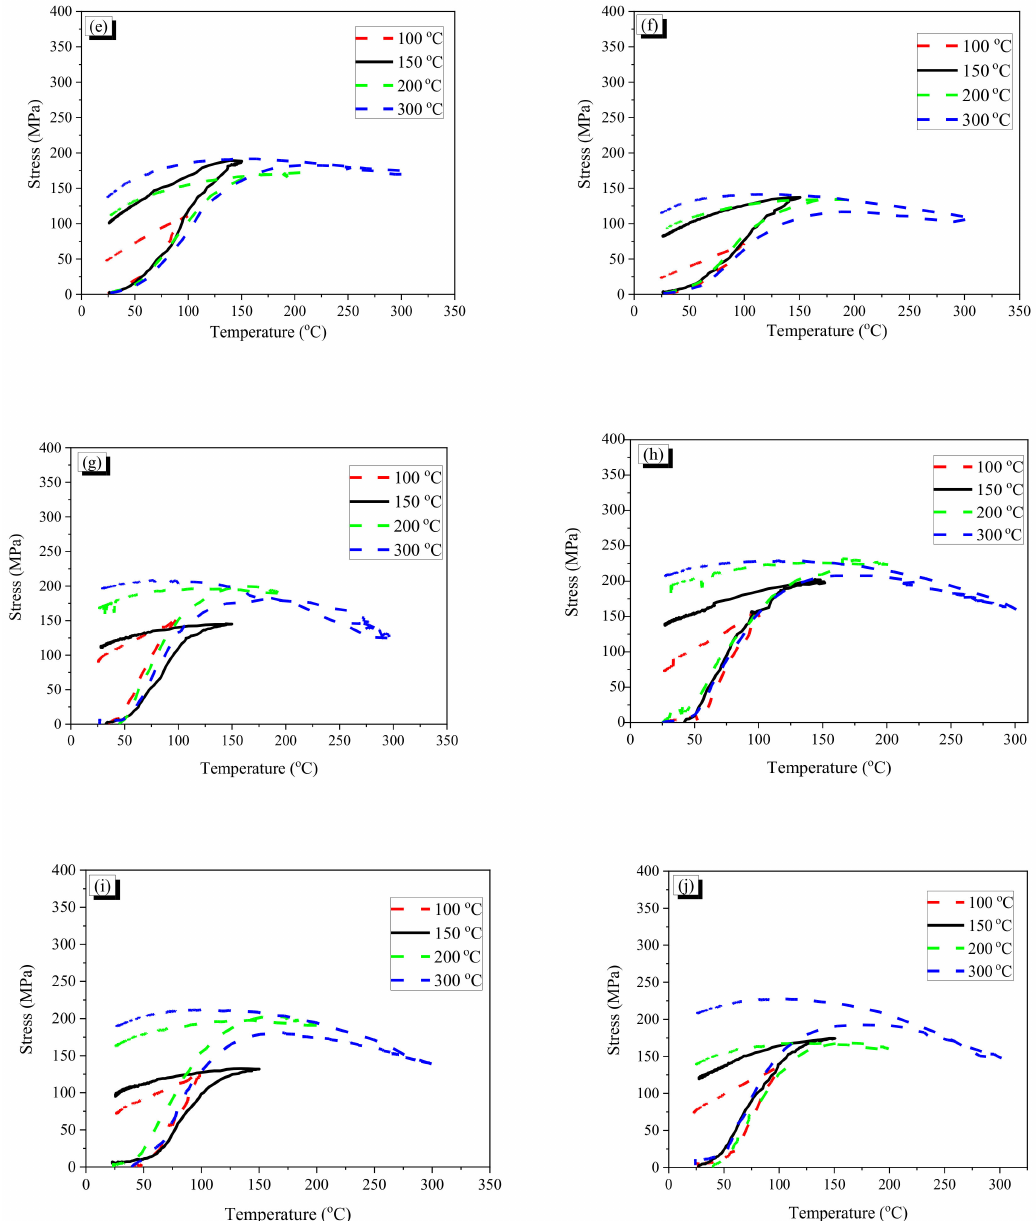
Figure 8. Temperature–stress curves of AR and crimped fibers: ( a ) AR1.0 fiber; ( b ) AR0.7 fiber; ( c ) CR1.0-1 fiber; ( d ) CR1.0-2 fiber; ( e ) CR1.0-3 fiber; ( f ) CR1.0-4 fiber; ( g ) CR0.7-1 fiber; ( h ) CR0.7-2 fiber; ( i ) CR0.7-3 fiber; and ( j ) CR0.7-4